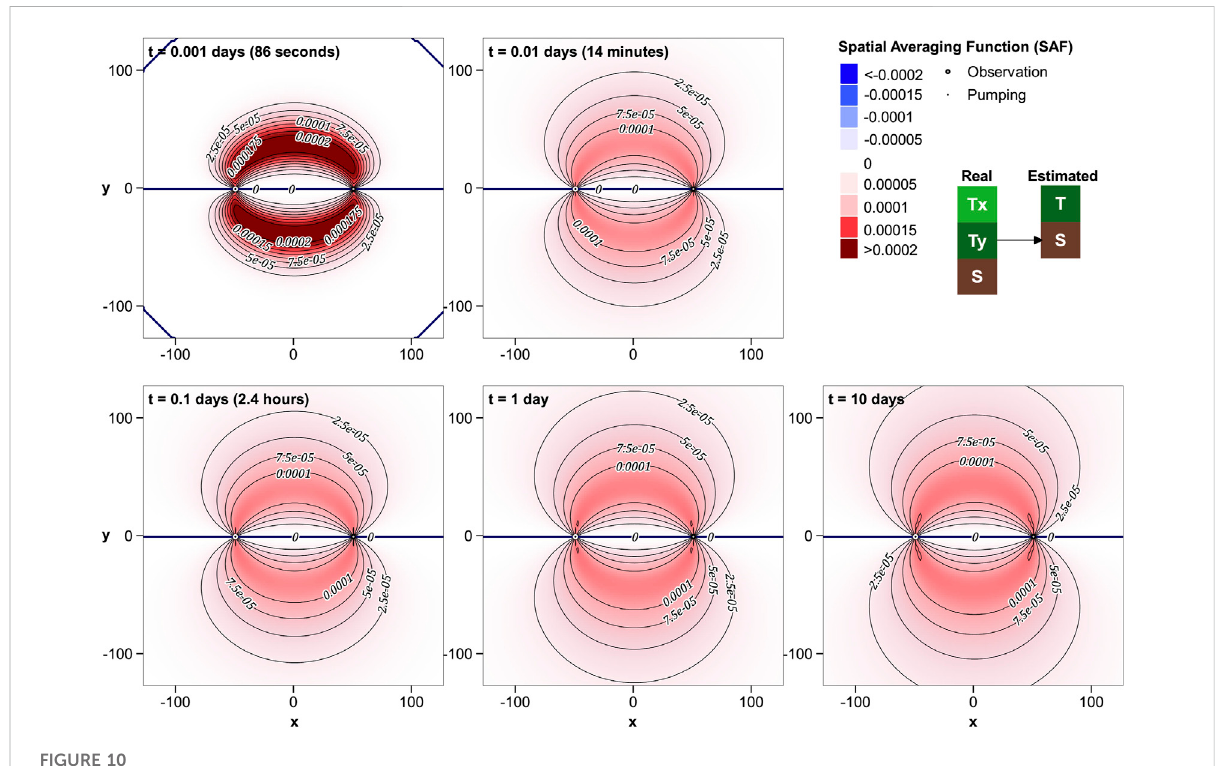
FIGURE 10 R ′ S − Ty for separated wells at fi ve different